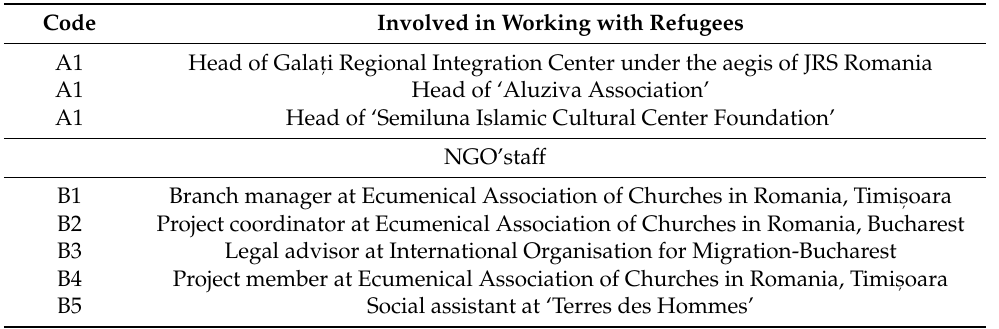
Table 2. List of NGO